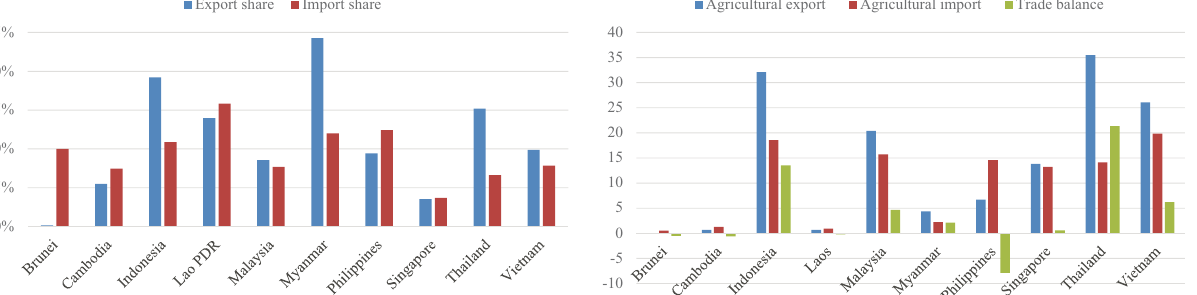
Figure 3: The agricultural trade of the ASEAN, 2019 ( billion USD ) .